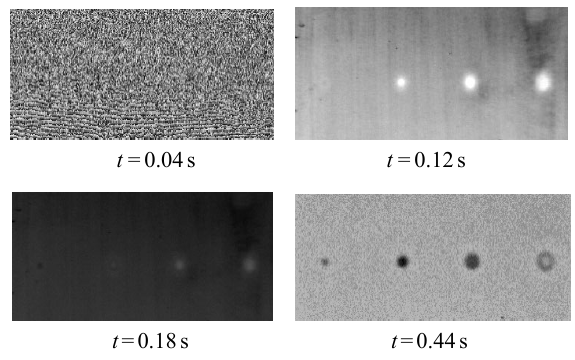
Fig. 10 Thermal image sequence after using the first-order differential processing.